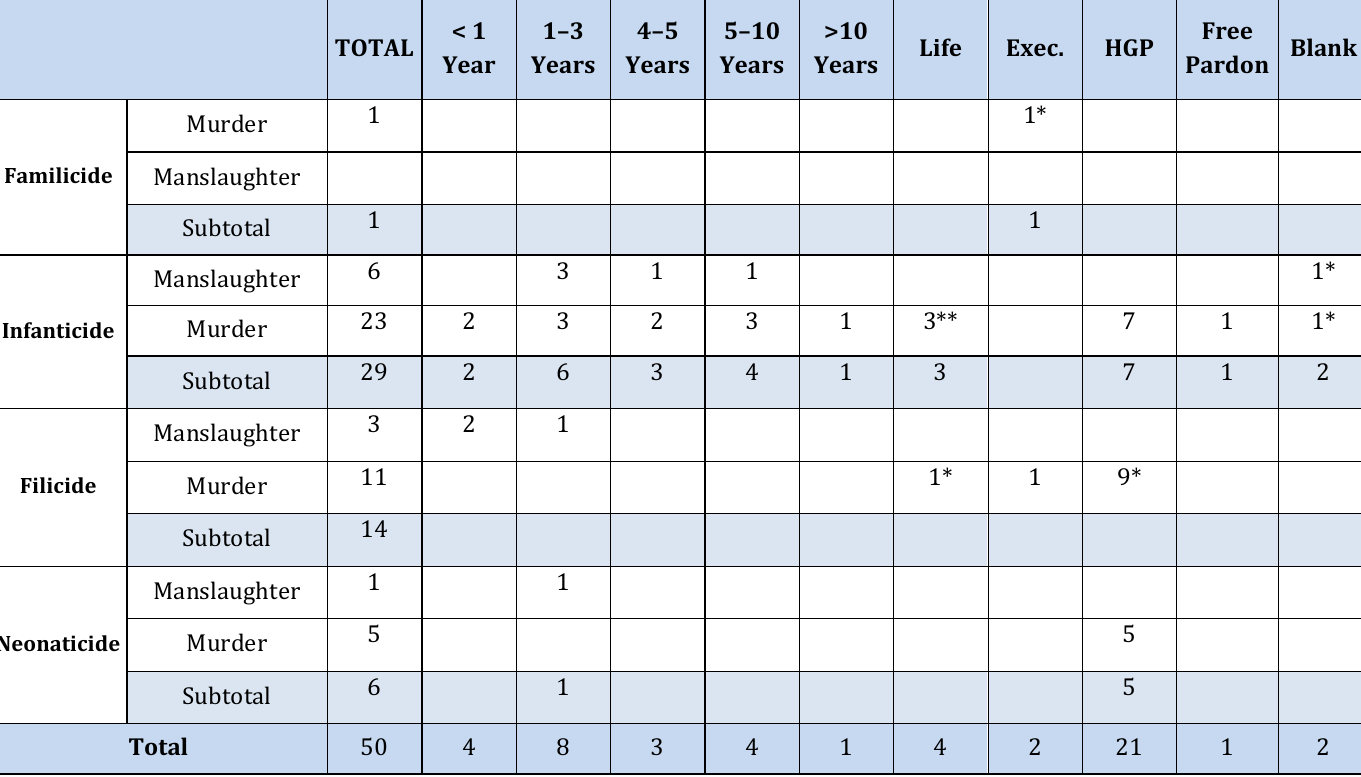
Table 2: Imprisonment Duration for Filicide Offenders, Victoria, 1860 – 1920